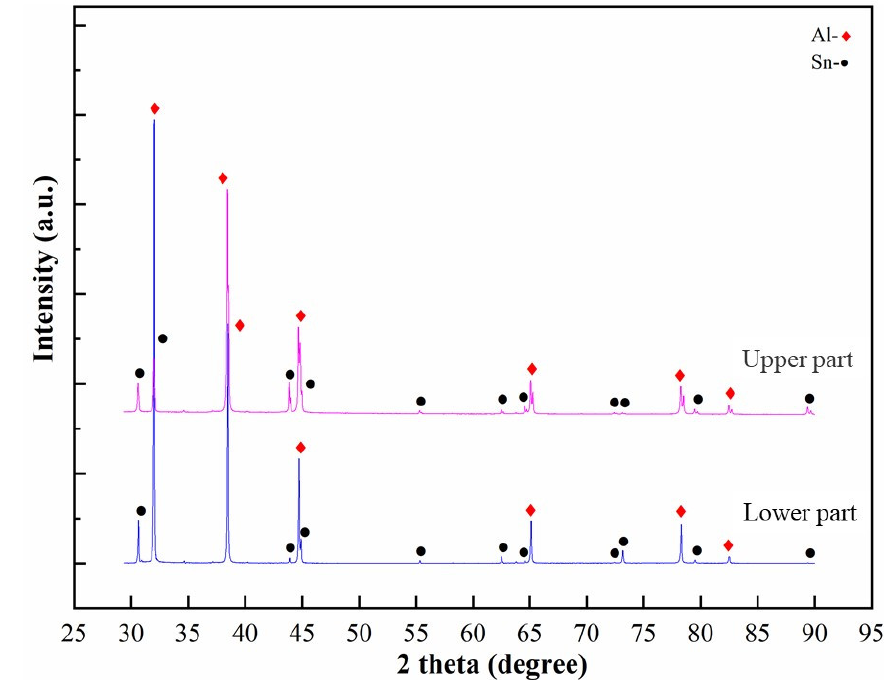
Figure 6. XRD analysis of semi-continuously cast AlSnCu alloy.